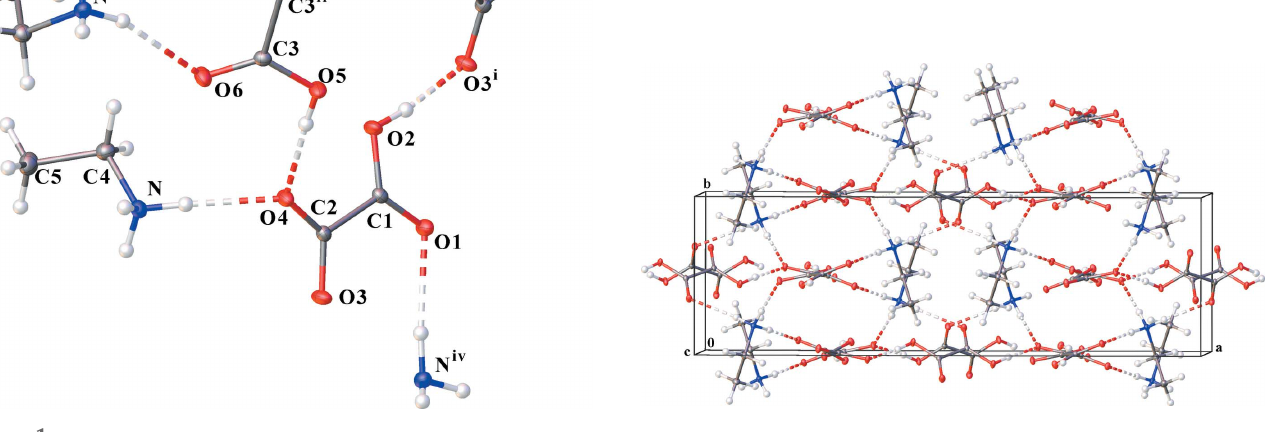
Figure 2 The packing, viewed along the c axis, showing the intermolecular hydrogen-bonding scheme (dashed lines) [colour code: C dark grey, H white, O red, N blue].